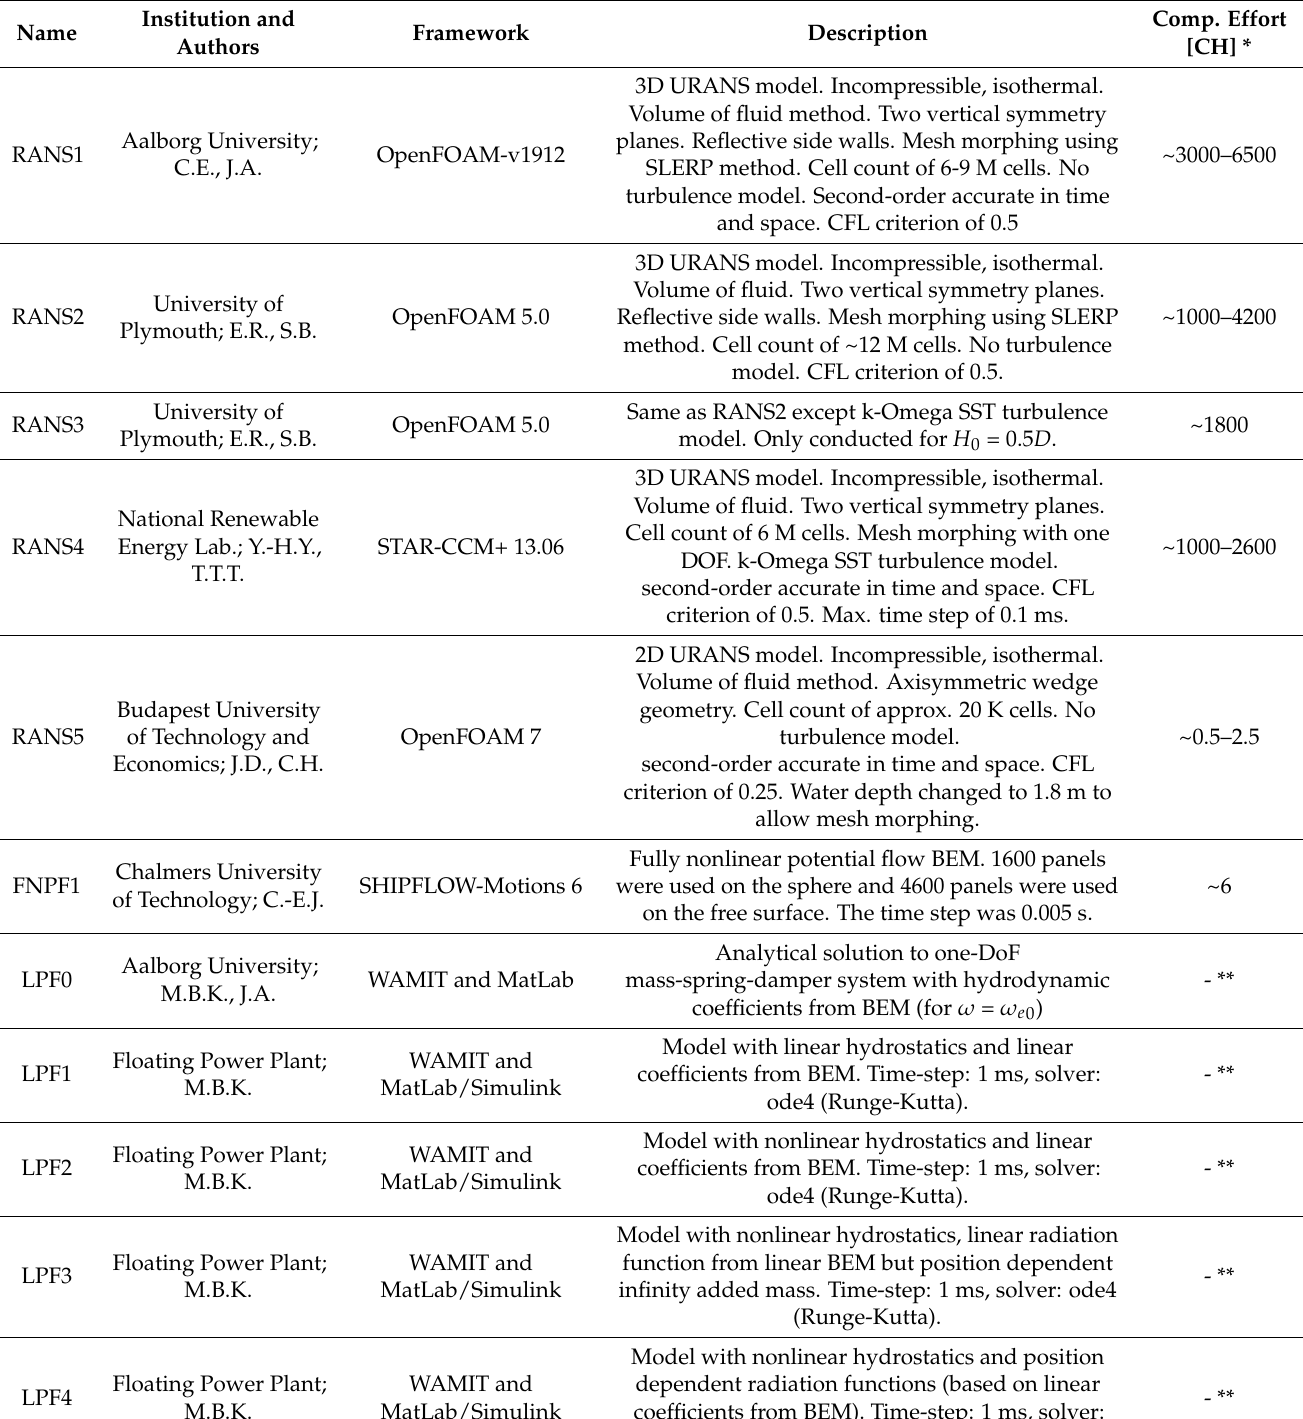
Table A1. Numerical models from the participants in the OES working